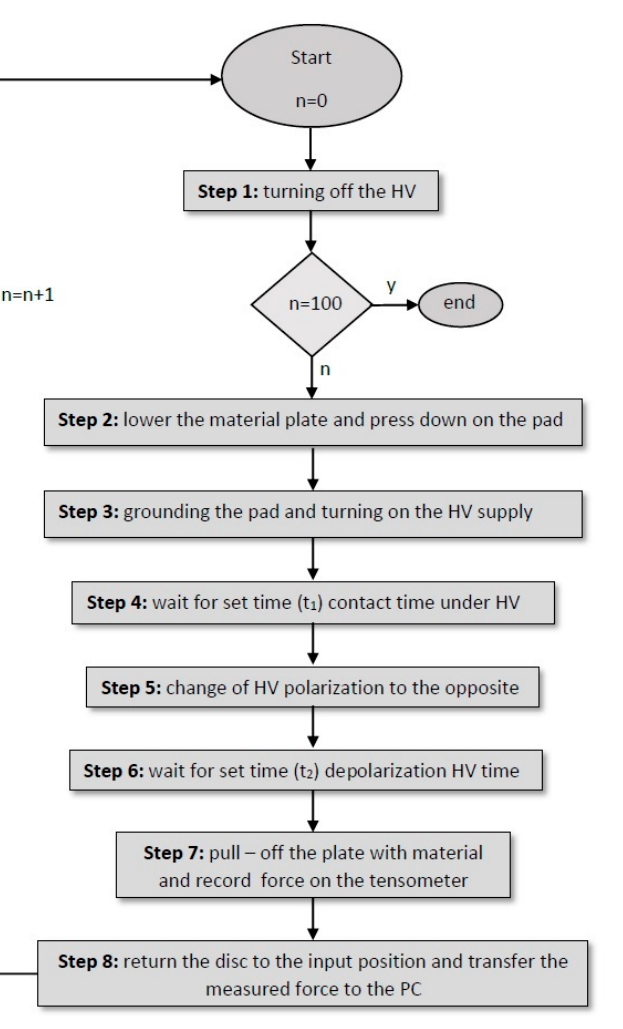
Figure 5. Block diagram of the algorithm followed throughout the measurements using the electroadhesive force.